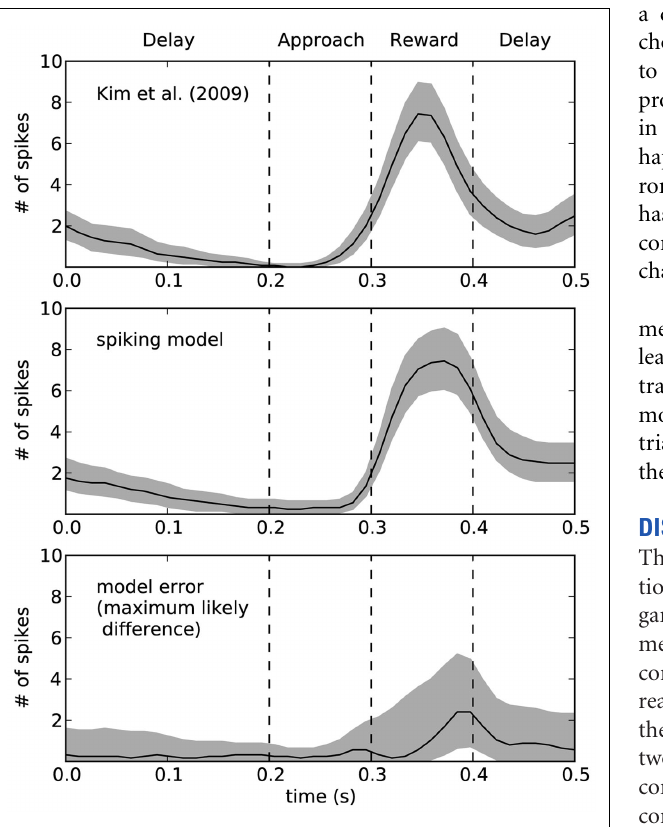
FIGURE 9 | Ninety five percentage bootstrap confidence intervals for the spike counts of the model and the empirical data. Bottom graph shows the difference between these models, where the black line is the average difference and the top of the gray area shows the maximum likely difference (MLD; Stewart andWest, 2010). MLD indicates that we can be 95% confident that the model produces behavior that is accurate to within this value, thus placing an upper bound on the error in the model.The bottom of the gray area indicates the lower bounds on the model error, such that whenever the gray area does not include zero we can find a statistically significant difference between the model and the empirical